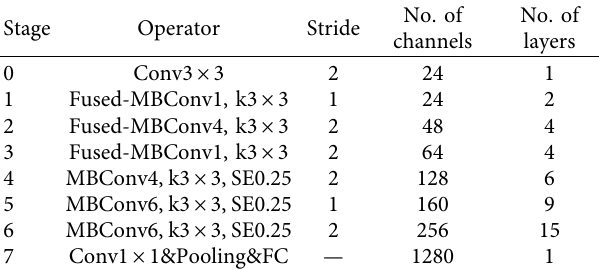
Figure 9: Structure of (a) MBConv and (b) Fused-MBConv. Table 6: Architectures of